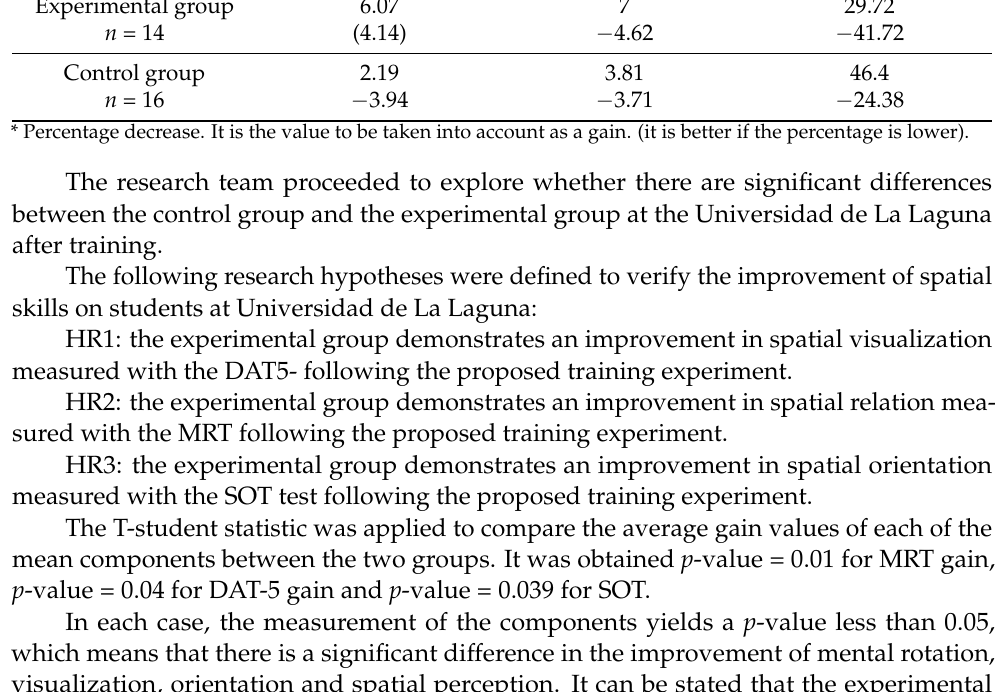
Table 5. Gain in scores for each of the spatial ability components. Gain MRT Gain DAT-5 Gain SOT * Mean Value (SD) Mean Value (SD) Mean Value (SD) Experimental group 6.07 7 29.72 n = 14 (4.14) − 4.62 − 41.72 Control group 2.19 3.81 46.4 n = 16 − 3.94 − 3.71 −